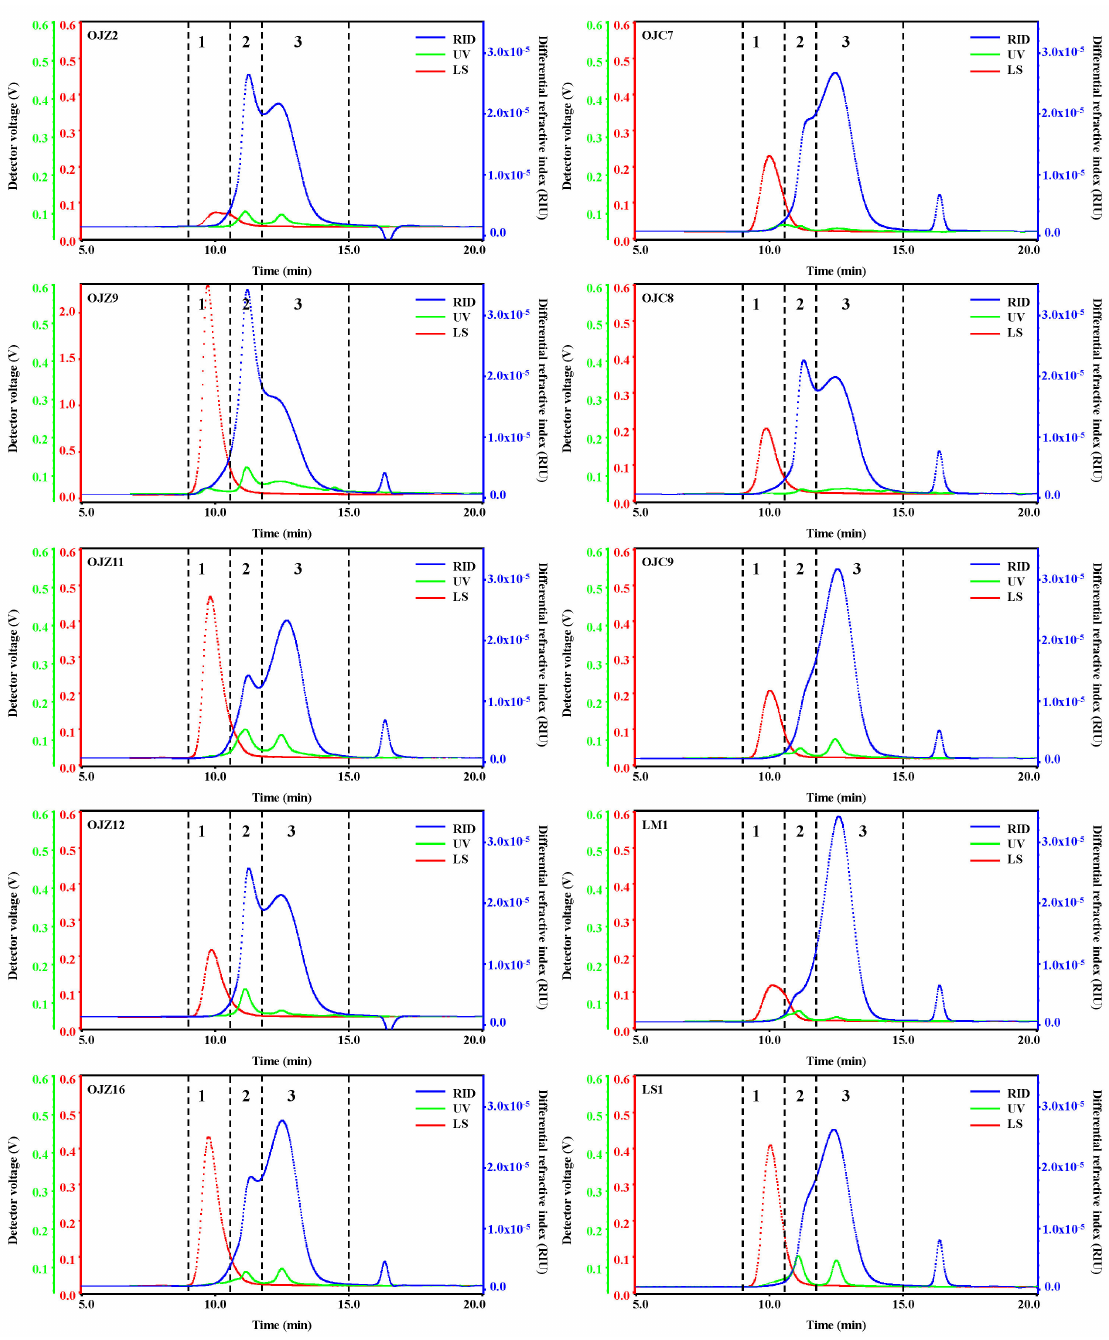
Figure 2. Representative HPSEC-MALLS-RID chromatograms with peaks 1, 2 and 3 of polysaccha- rides from different samples. The codes are the same as in Table